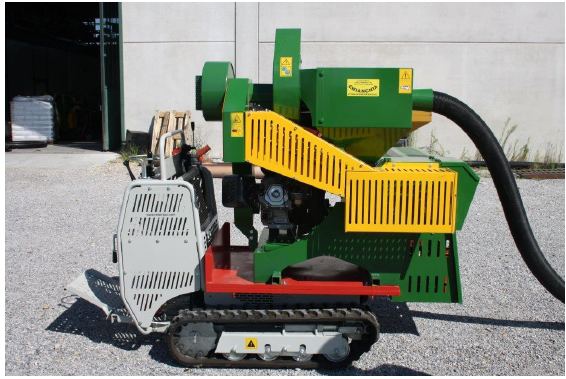
Figure 1. Photo of the small-scale machine for nuts harvesting proposed in the study of [44].